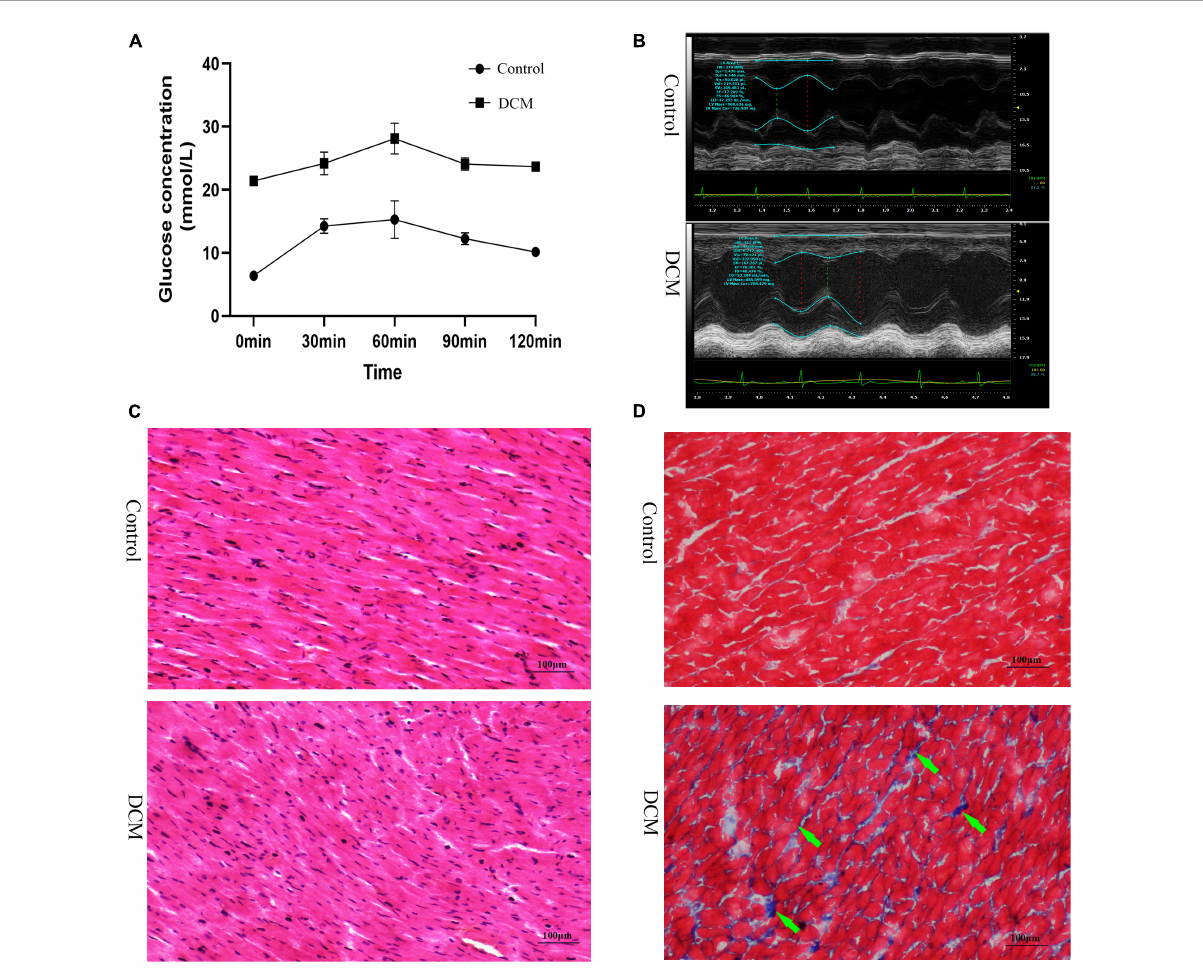
FIGURE1 Establishment of diabetic cardiomyopathy (DCM) rat modes. (A) The results of the oral glucose tolerance test (OGTT) ( n = 3 rats per group). (B) Representative M mode tracing of echocardiographs ( n = 3 rats per group). (C) Hematoxylin and eosin (H&E) staining of specimens from the control and DM groups ( n = 3 rats per group, scale bar = 100 µ m). (D) Masson staining specimens from the control and DM groups ( n = 3 rats per group, scale bar = 100 µ m). The green arrows represent the blue collagen